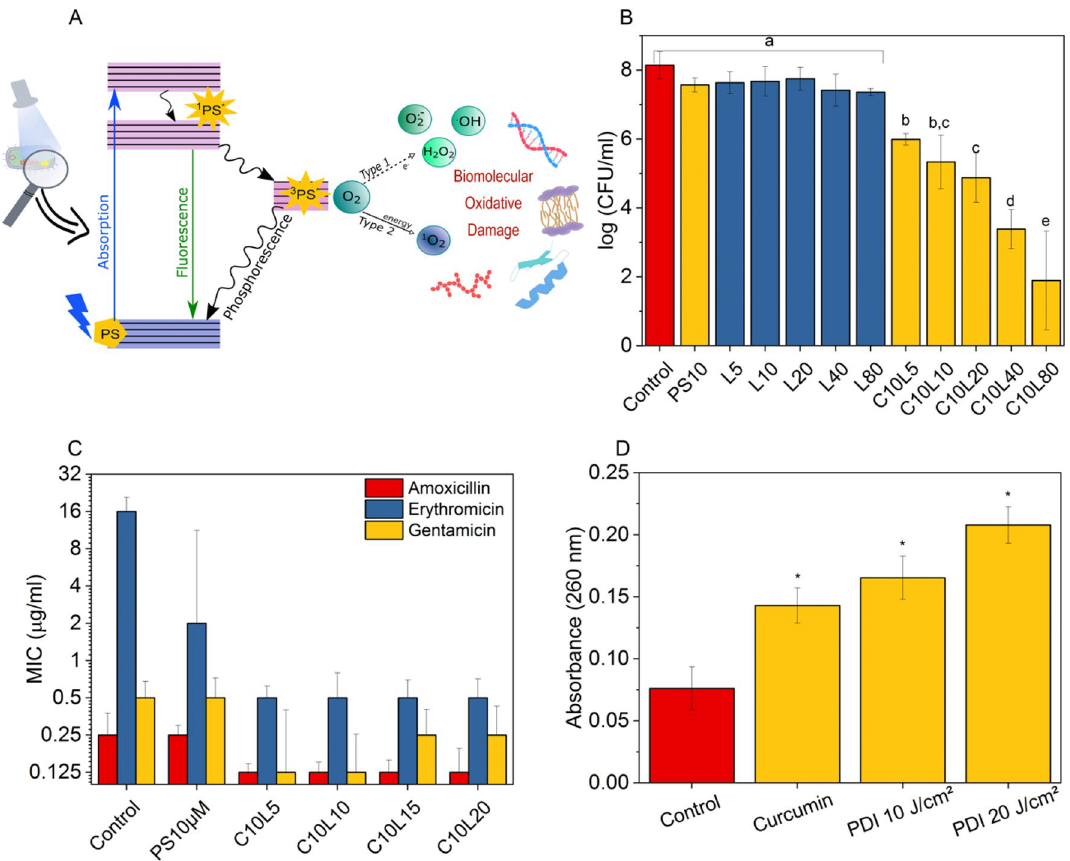
Figure 1. Photodynamic inactivation (PDI) and antibiotic therapy. ( A ) Mechanism of PDI action represented by Jablonski diagram. ( B ) Survival of S. aureus with curcumin dark control 10 μM (PS10) curcumin dark control, 5 to 80 J/cm 2 (L) control light doses, and PDI with fixed PS concentration for different light doses (C10L). Different letters indicate statistically significant difference p < 0.05. ( C ) Standard Minimum Inhibitory Concentration (MIC) (control) values for amoxicillin, erythromycin, and gentamicin in combination (or not) with PDI. ( D ) Determination of membrane permeability by the presence of extracellular DNA in bacteria exposed to 10 μM of curcumin in the dark and with a light dose of 10 and 20 J/cm 2 . * indicates statistically significant difference p <